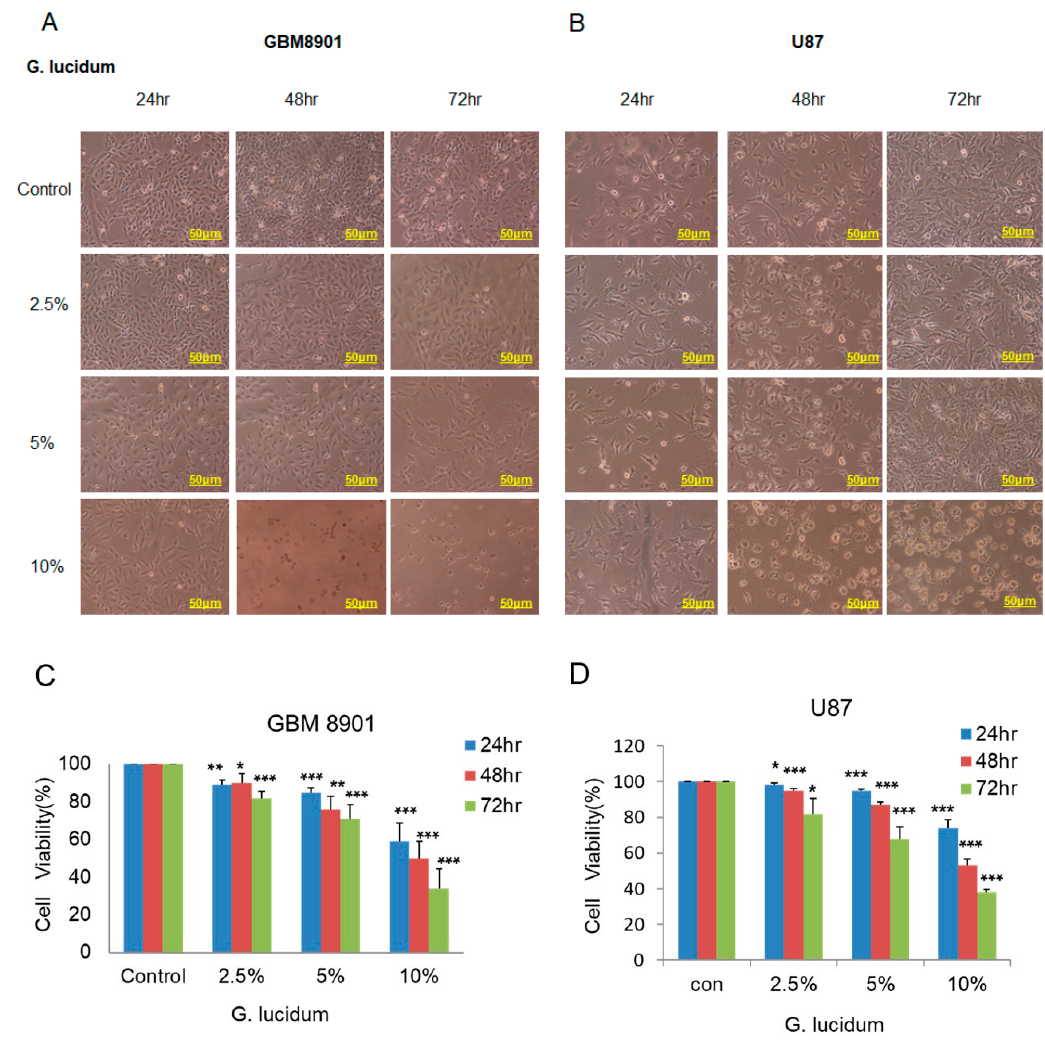
Figure 1. G. lucidum extract inhibits the growth of human glioblastoma cells. ( A , B ) The phenotype of ( A ) GBM8901 and ( B ) U87 cells treated with different concentrations of G. lucidum for 24, 48, and 72 h. ( C , D ) Cell survival of ( C ) GBM8901 and ( D ) U87 cells was examined using the MTT assay. * p < 0.05; ** p < 0.01; *** p < 0.001.